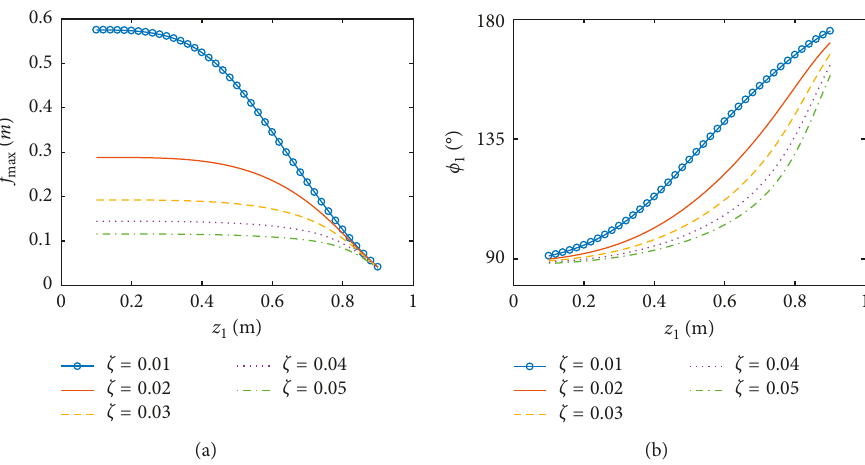
Figure 12: The amplitudes and the phases of the surface wave height versus the position of the flexible baffle for R (a) the amplitude of the surface wave height, (b) the phase of the surface wave height.